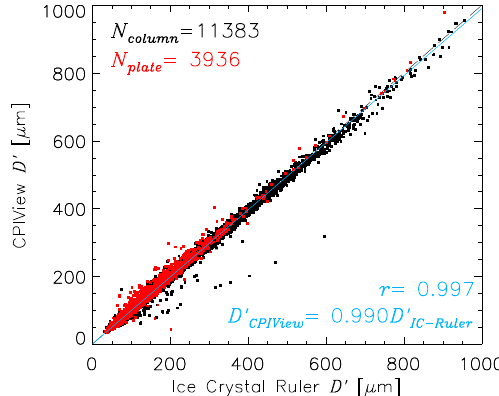
Figure 3. A comparison between the projected maximum dimen- sion ( D (cid:48) ) of columns (black) and plates (red) measured using the Ice Crystal Ruler (IC-Ruler) and those obtained from CPIView. Corre- lation coefficient ( r ) and slope of best fit line of CPIView D (cid:48) against D (cid:48) from IC-Ruler embedded in the panel. The black dashed line is a 1 : 1